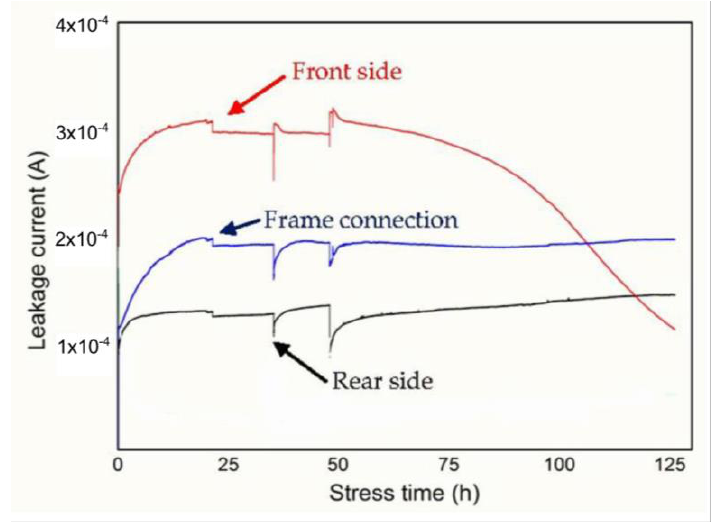
Figure 12. Leakage current progress during tests with high positive voltage of 1000 V.